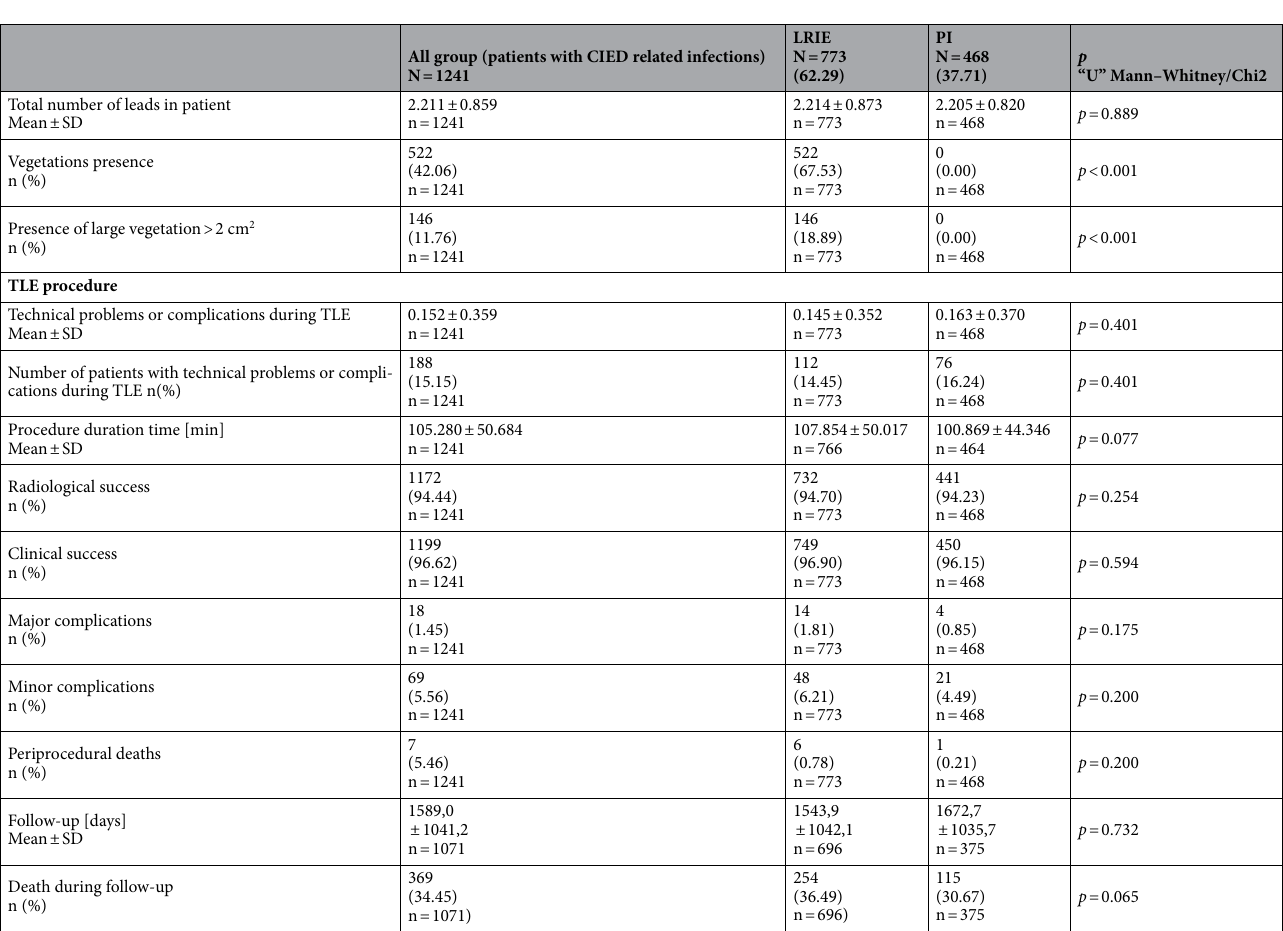
Table 1. Demographic and clinical data of patients admitted for lead extraction due to infection. AF, atrial fibrillation; CIED, cardiac implantable electronic devices; CKD, chronic kidney disease; eGFR, glomerular filtration rate; ICD, implantable cardioverter defibrillator; LRIE, lead related infective endocarditis, LVEF, left ventricular ejection fraction, PI, pocket infections, SD, standard deviation, TLE, transvenous lead